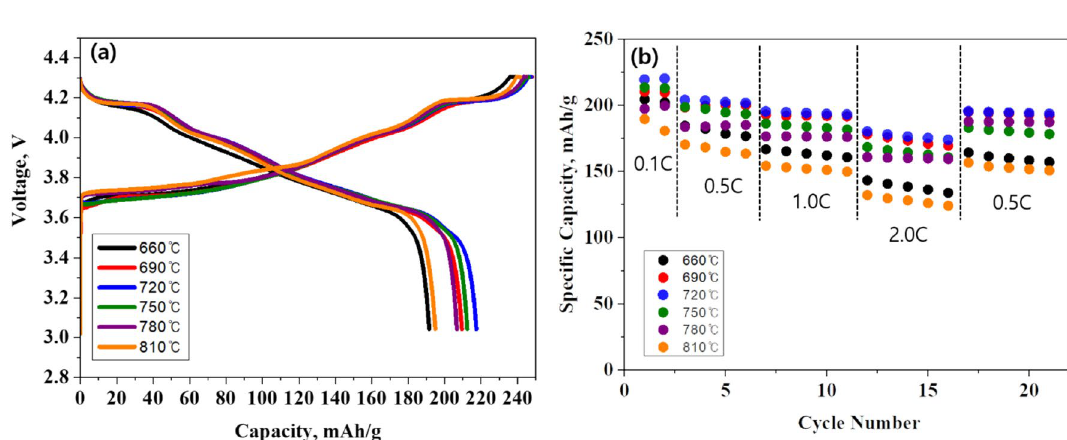
Figure 4. ( a ) Initial charge–discharge curves and ( b ) rate performances of